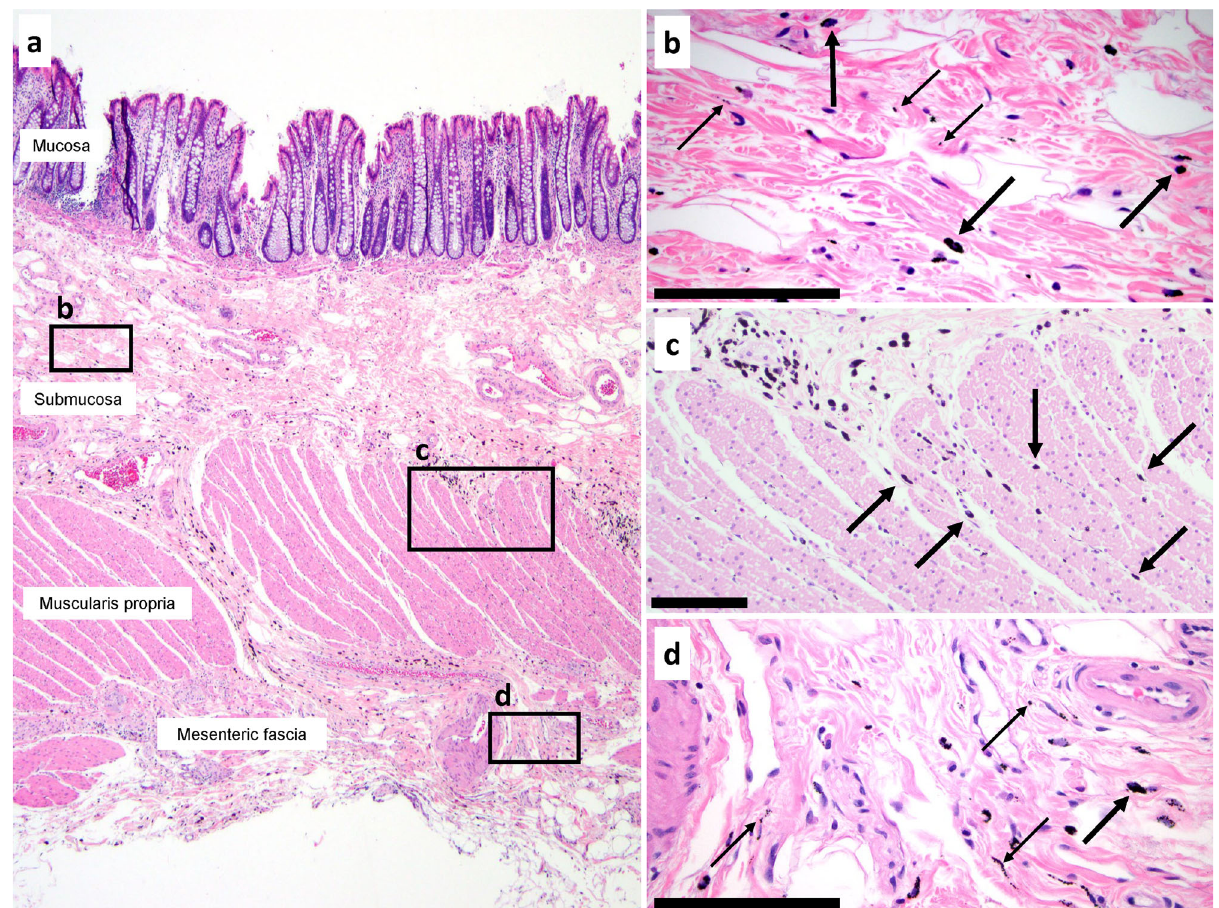
Fig. 2 Tattoo pigment in interstitial spaces of the colon and mesenteric fascia. a H&E section of colon resection specimen with endoscopically injected tattoo pigment. Pigment particles are present in submucosa, muscularis propria, and mesenteric fascia. b Higher magni fi cation view of the submucosa demonstrates both intracellular particles (within macrophages; thick arrows) and extracellular particles (within interstitial spaces; thin arrows). c Intermediate power view of the muscularis propria shows pigment-containing macrophages (thick arrows) within interstitial spaces between muscle bundles (compare to Supplementary Figs. 6c, d for a similar display of movement by carcinoma). d Mesenteric fascia has intracellular and intercellular pigment as seen in all other layers. Scale bars = 100 μ